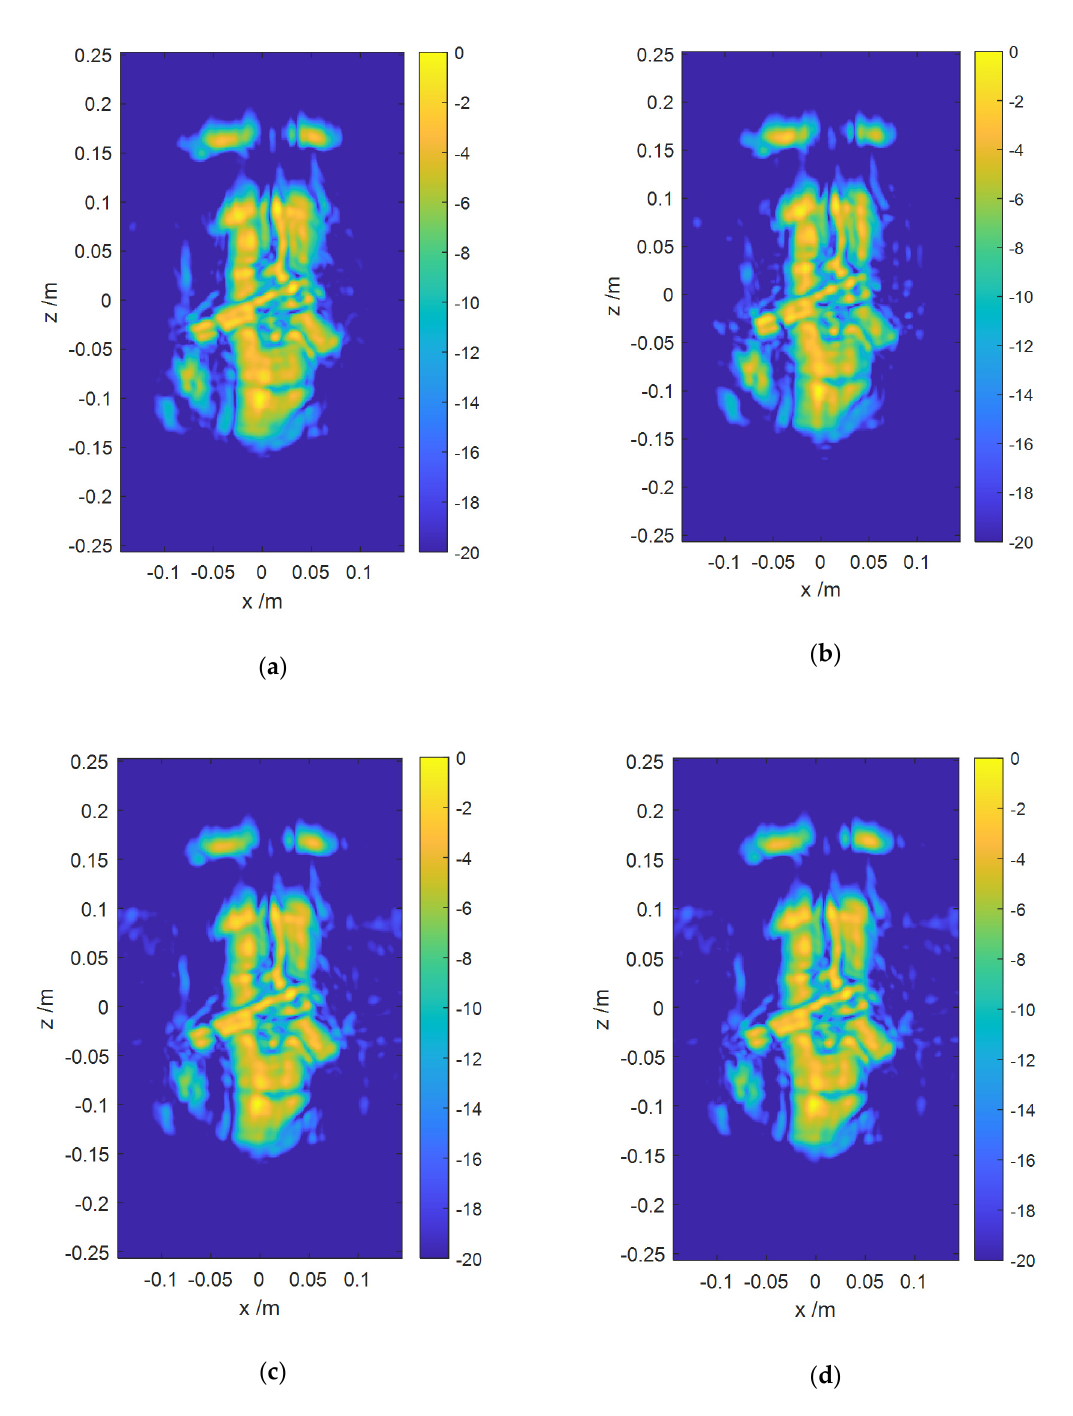
Figure 14. Imaging results of the man model with a coat: ( a ) Imaging results of the proposed algorithm for ARRAY C; ( b ) Imaging results of Enhanced algorithm for ARRAY C; ( c ) Imaging results of the proposed algorithm for ARRAY D; ( d ) Imaging results of BP algorithm for ARRAY D.